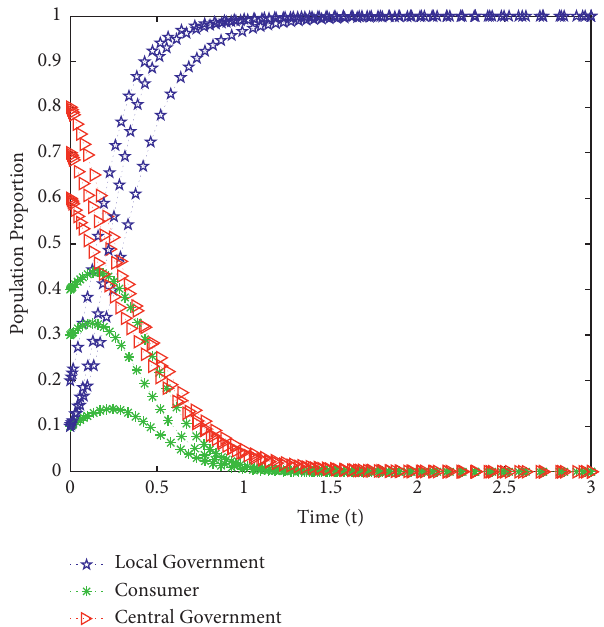
Figure 9: Evolution path of strategies chosen by three players with the stability point E